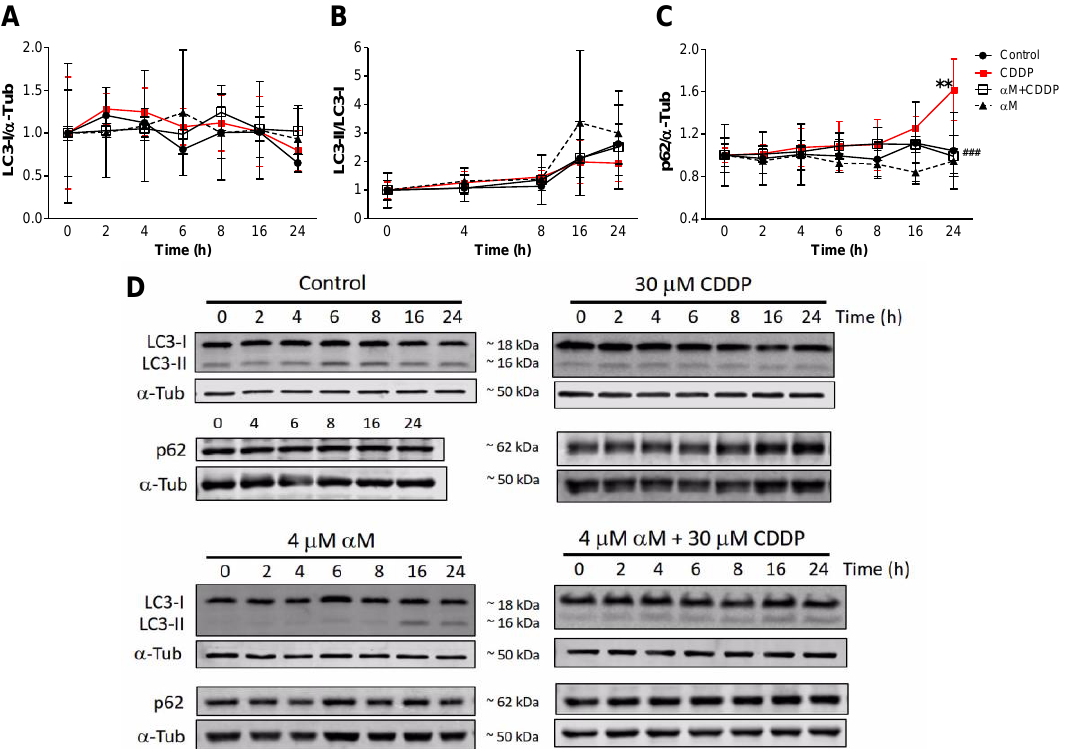
Figure 10. Time-course e ff ect of α M and CDDP on autophagy stress markers. LLC-PK1 cells were incubated with 4 µ M α M, 30 µ M CDDP or both during 0, 2, 4, 6, 8, 16, and 24 h. After each treatment, ( A ) microtubule-associated protein 1 light chain 3 alpha I (LC3-I), ( B ) lipidated form of LC3 (LC3-II), and ( C ) ubiquitin-binding protein p62 (p62) protein levels were evaluated. Panels A, B, and C show quantitative data, and panel D shows representative blots. Data are presented as mean ± SD, n = 3–5. ** p < 0.01 vs. control and ### p < 0.01 vs. CDDP. α -Tub = alpha-tubulin.